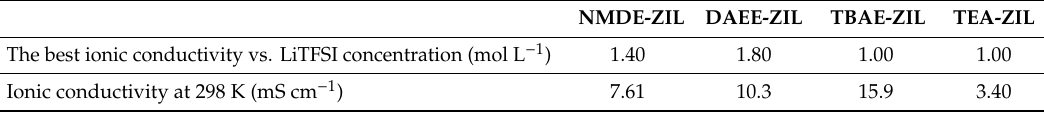
Table 9. The optimum ionic conductivity of 1:1 weight ratio of ZIL / 2-NP mixtures containing optimum LiTFSI